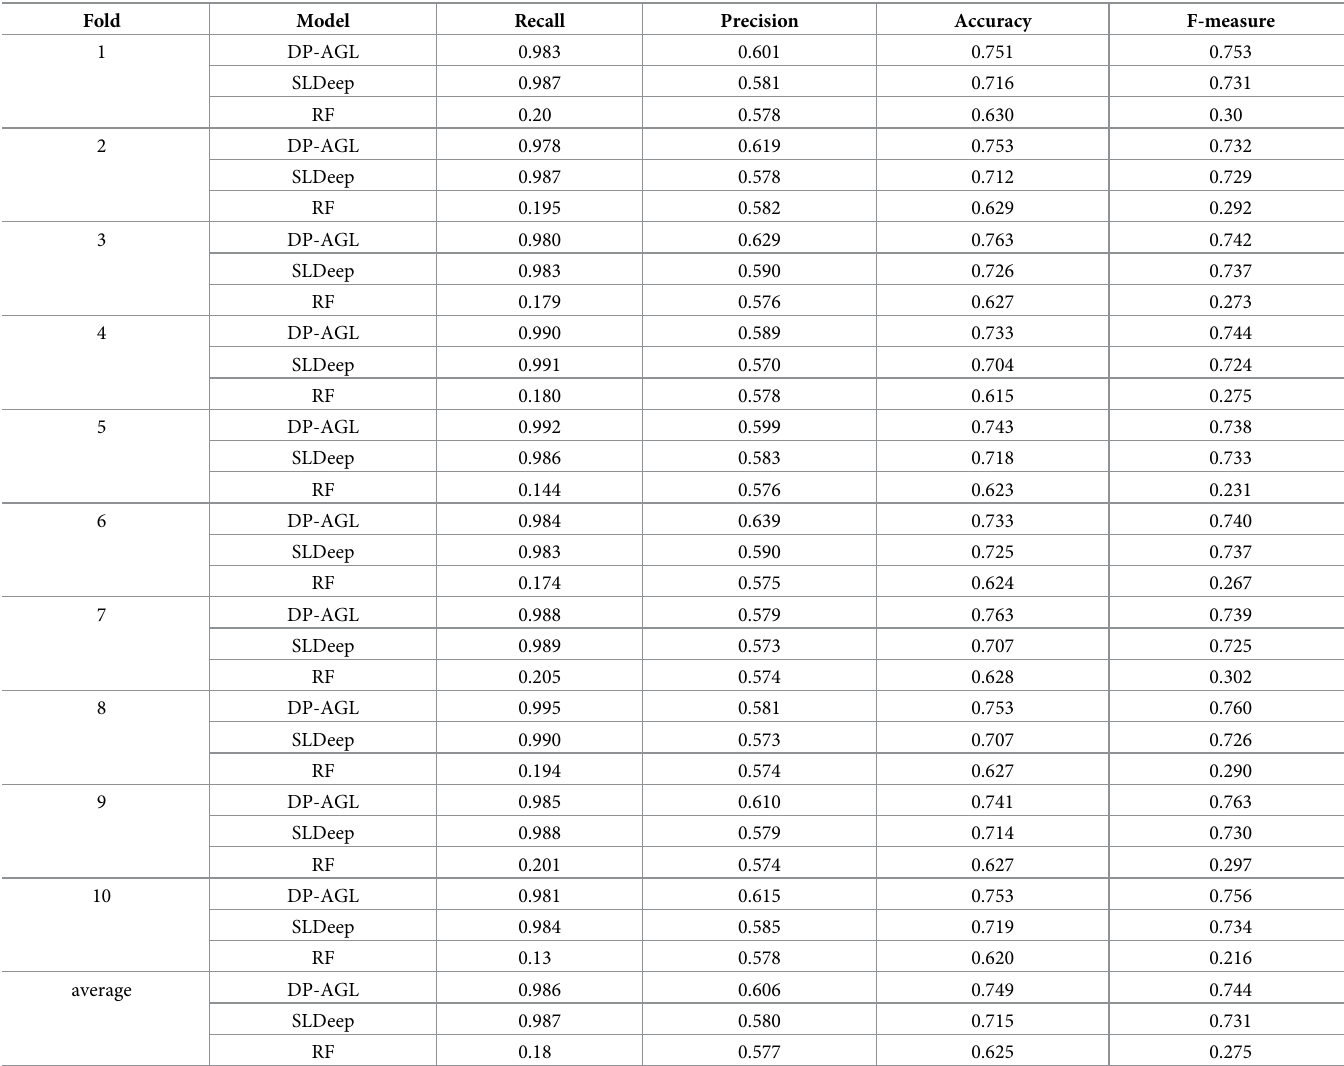
Table 3. Experimental results on training with accuracy neighborhood 4.